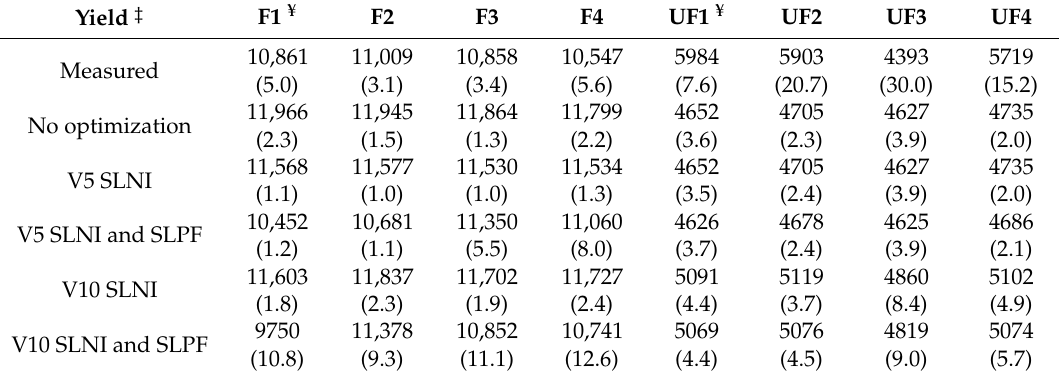
Table 5. Average measured and simulated maize yield (kg ha − 1 ) with coe ffi cient of variation (%; in parenthesis) of nitrogen (N)-fertilized and unfertilized strips, with and without spatial